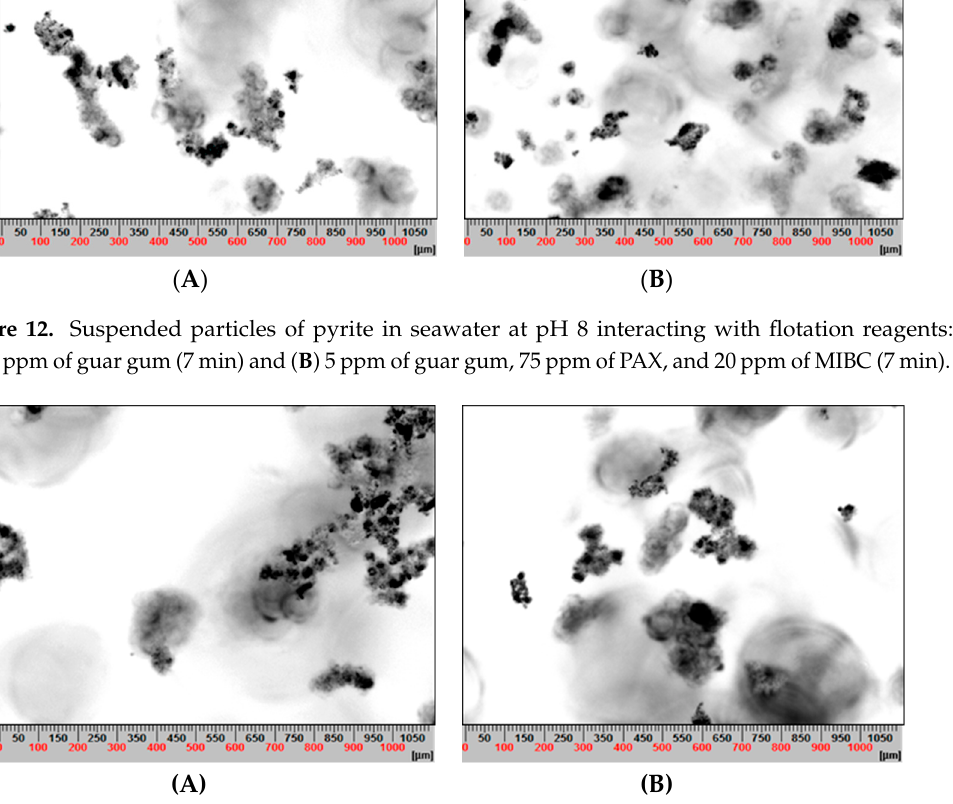
Figure 13. Suspended particles of pyrite in seawater at pH 8 interacting with flotation reagents: ( A ) 100 ppm of guar gum (7 min) and ( B ) 100 ppm of guar gum, 75 ppm of PAX, and 20 ppm of MIBC (7 min).